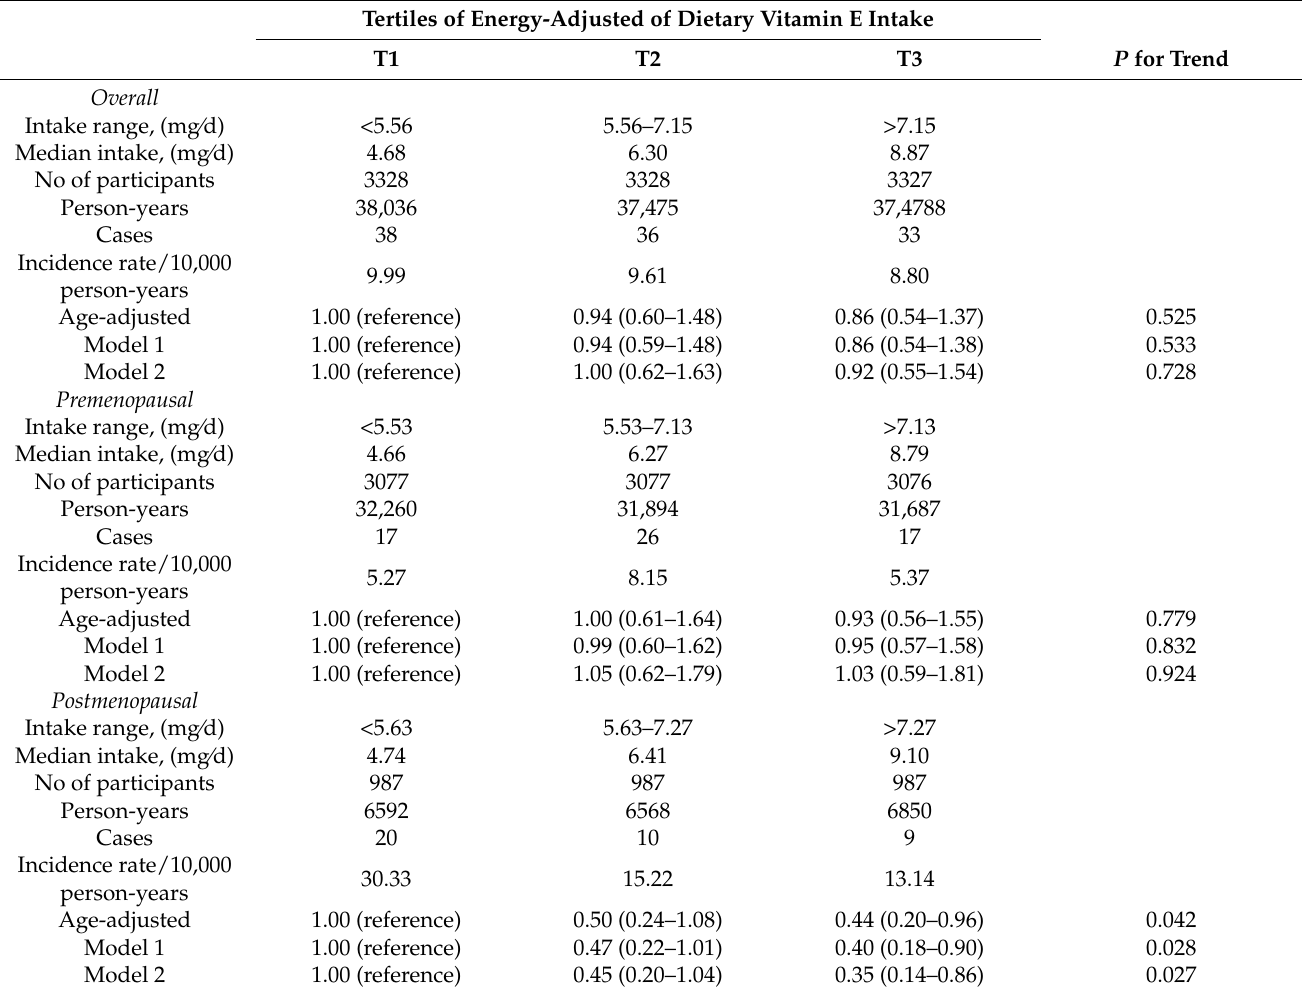
Table 4. Dietary vitamin E intake. Hazard Ratio (HR) and 95% Confidence Interval (CI) of breast cancer by tertiles of energy-adjusted dietary vitamin E at baseline among female participants of the SUN cohort. Tertiles of Energy-Adjusted of Dietary Vitamin E Intake T1 T2 T3 P for